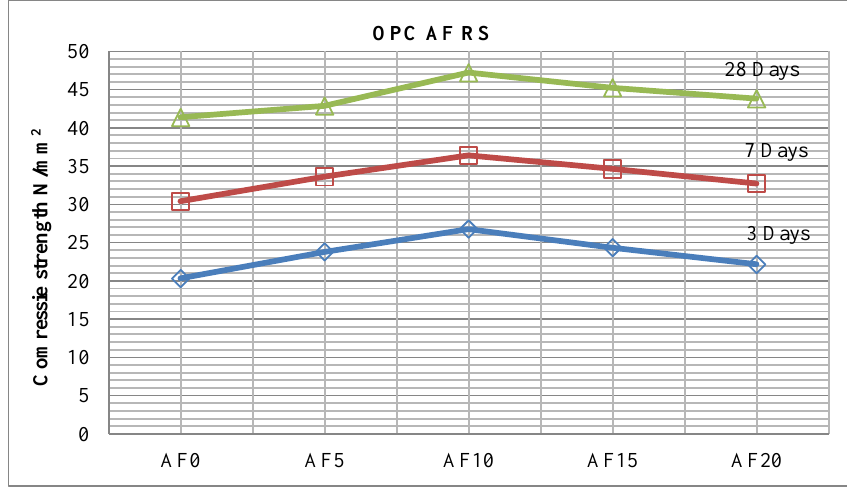
Figure 12. Mortar cube compressive strength at different age.